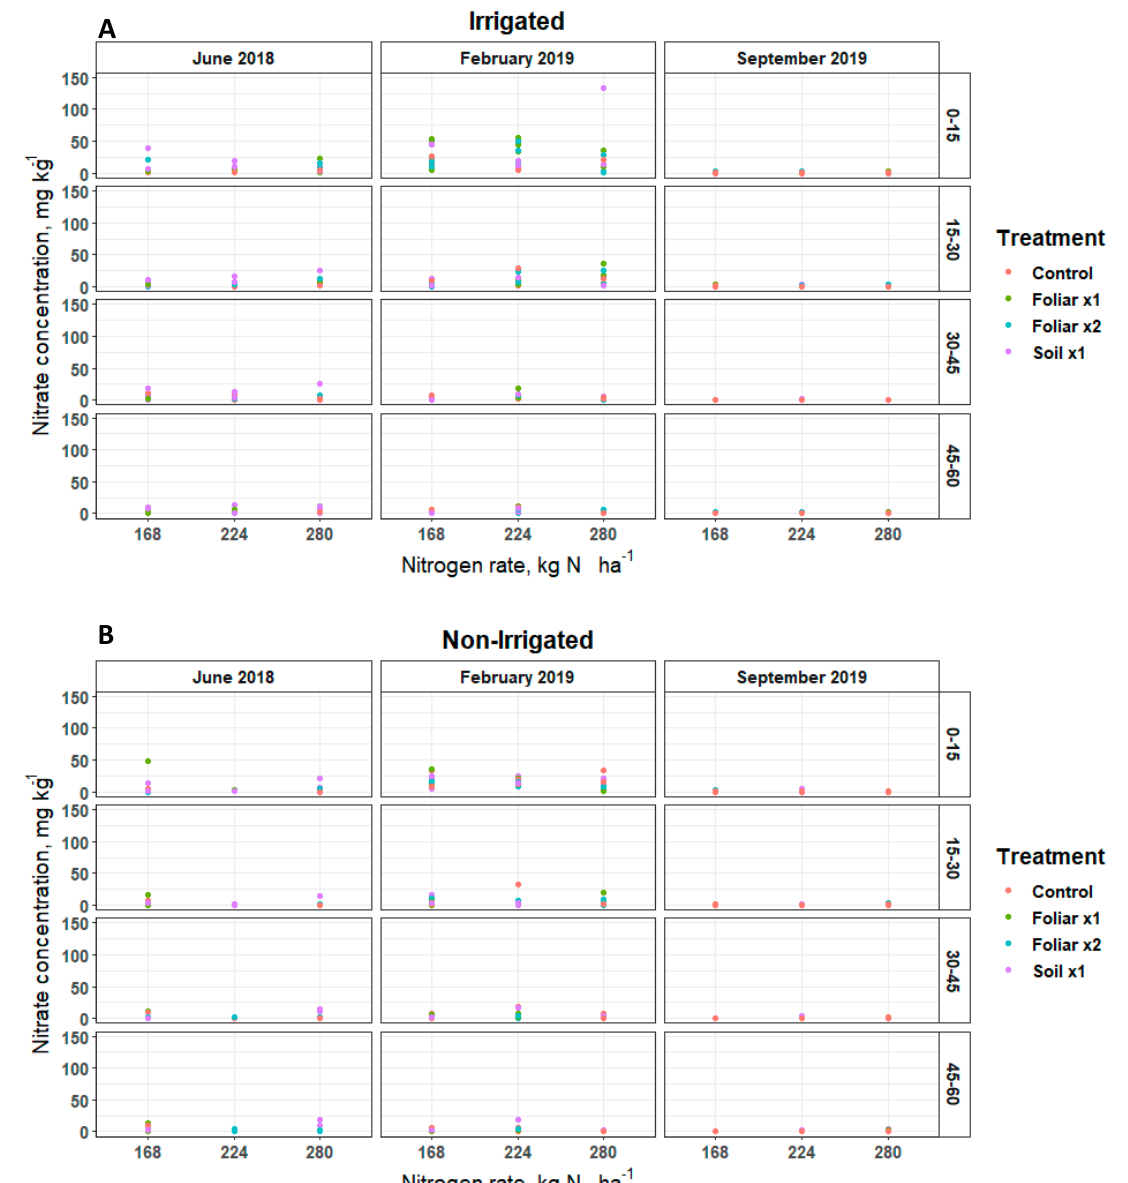
Figure 1. Soil NO 3 -N distribution in a Florida sandy soil after application of three levels of nitrogen in irrigated ( A ) and non-irrigated ( B ) zones at 0–15, 15–30, 30–45 and 45–60 cm soil depths for three replicates. Treatments: control—standard soil Zn applied; foliar x1—standard soil Zn applied + foliar-applied Zn based at 1 × UF / IFAS recommendations; foliar x2—2 × foliar-applied Zn at UF / IFAS recommendations + standard soil Zn application; soil x1—2 × soil-applied UF / IFAS recommendations (5.60 kg Zn ha − 1 ).